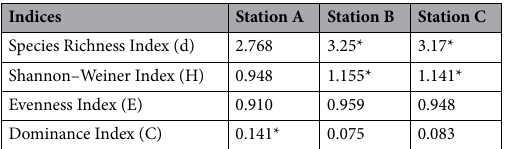
Table 5. Diversity indices of zooplankton in the river. Asterisked values are significantly higher at p <